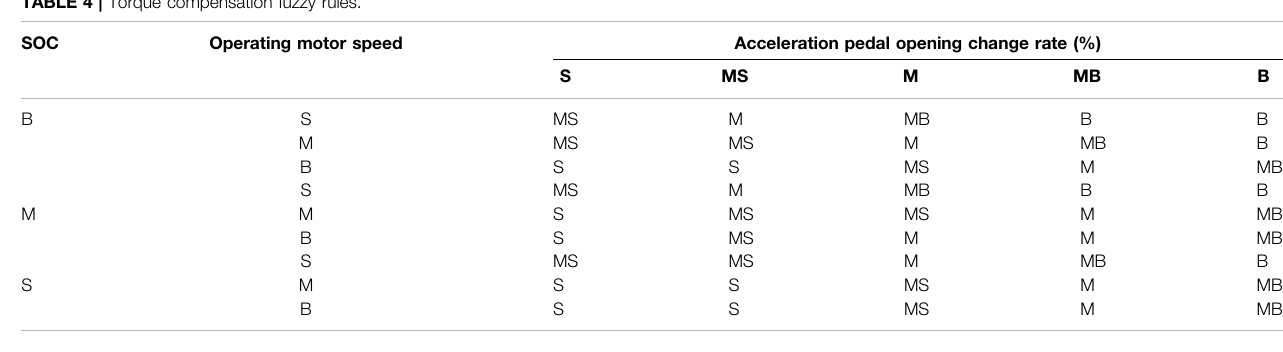
TABLE 4 | Torque compensation fuzzy